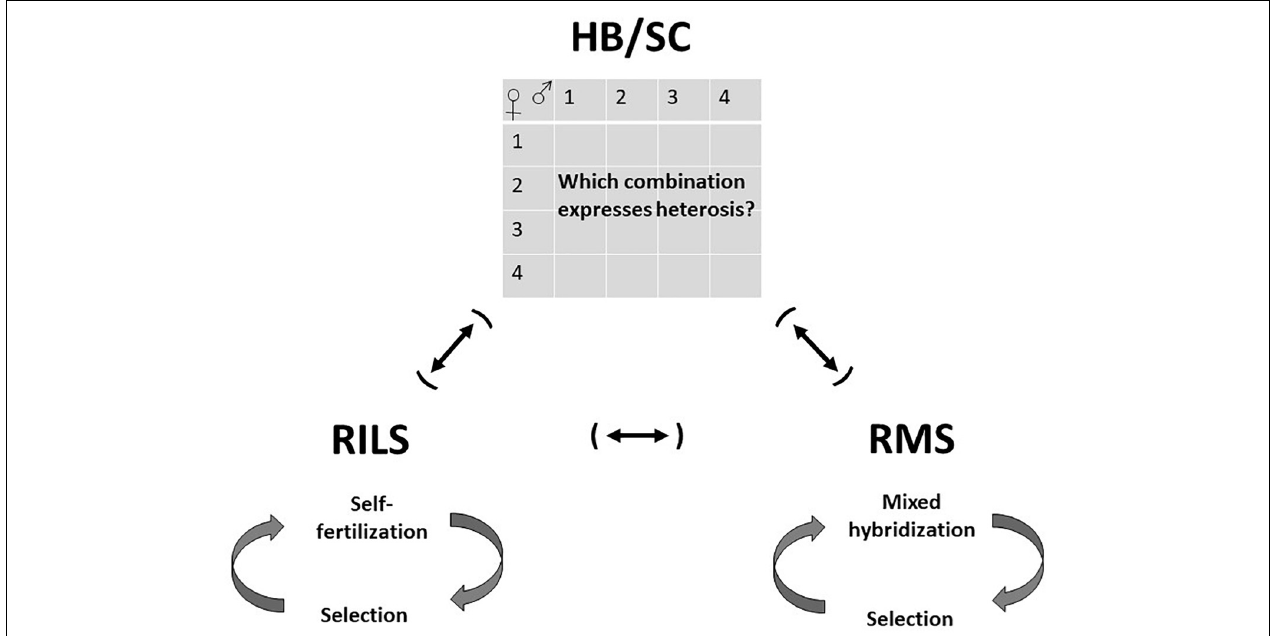
FIGURE 2 | Simplified illustration of breeding schemes employed in cultivar development of Laminarialean kelp species. HB/SC; hybrid breeding/selected crosses. The cultivar is the F1 offspring of a planned cross between divergent parents, resulting in considerable heterosis. Hybrids can be the result of interspecific hybridization or crosses within species (e.g., between individuals with different geographic origin or complementary traits). Selection of individual parents is often made on the basis of heterosis, that is the performance of F1 offspring from pair crosses between single gametophyte clones. RILS; recurrent inbred line selection. Desirable individuals are self-fertilized, the best offspring selected, and the cycle repeated several times. RMS; recurrent mixed hybridization and mass selection. Desirable individuals are selected from a population (without progeny testing) and subjected to mixed hybridization, and the cycle repeated several times. This type of selection exploits additive genetic variance and a large part of the genetic diversity in the population can be maintained. Both RILS and RMS can be combined with HB/SC in any